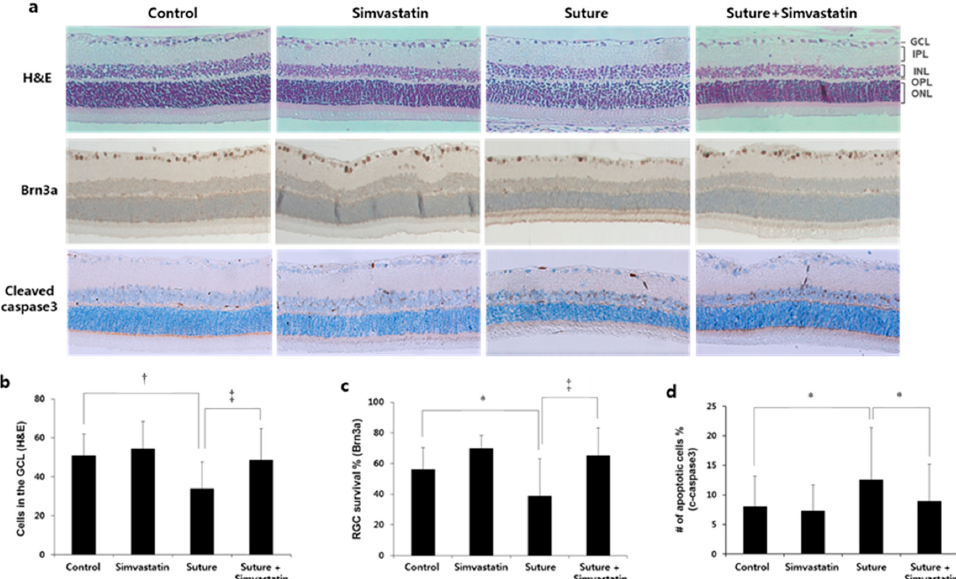
Figure 3. Simvastatin protects RGCs from chronic OHT-induced cell death. ( a ) The retinas were either stained with H&E or processed by immunohistochemistry for Brn3a or cleaved caspase-3. Number of cells ( b ), number of Brn3a + cells ( c ), and cleaved caspase-3 + cells ( d ) in the GCL were quantified. The number of RGCs was reduced and the number of cleaved caspase-3 was increased in the sutured retina. Simvastatin injection prevented RGC death and suppressed apoptosis. GCL: Ganglion cell layer, IPL: inner plexiform layer, INL: inner nuclear layer, OPL: outer plexiform layer, ONL: outer nuclear layer, RGCs: retinal ganglion cells, H&E: hematoxylin and eosin, OHT: ocular hypertension; * p < 0.05, † p < 0.01, ‡ p < 0.001; n = 4 for each group. Glial activation is prominent in a damaged retina, and hypertrophic morphology and the upregulation of GFAP immunoreactivity in retinal astrocytes and Müller cells were reported in the retina of glaucoma patients [19]. In addition, the retinas that experienced chronic OHT, which is induced by the circumlimbal suture, exhibited the upregulation of GFAP expression [15, 20]. Therefore, we investigated the effect of statins on chronic OHT- induced glial activation. In the control retinas, basal expression of GFAP was detected in astrocytes (arrowhead) localized in the NFL, and few GFAP + processes of Müller cells